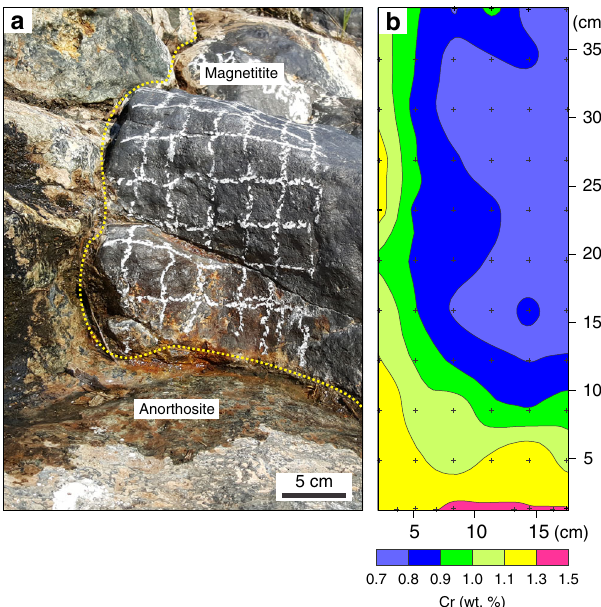
Fig. 5 Two-dimensional geochemical map of basal part of the Main Magnetite Layer with a sub-vertical footwall contact. Field photograph of the section and the corresponding geochemical contour map are shown in ( a ) and ( b ), respectively. Black crosses indicate the positions of individual data points. Geochemical contours remain subparallel with the footwall contact, indicating in situ nucleation and growth directly on the subvertical contact. The outcrop is located at Magnet Heights, Eastern Bushveld